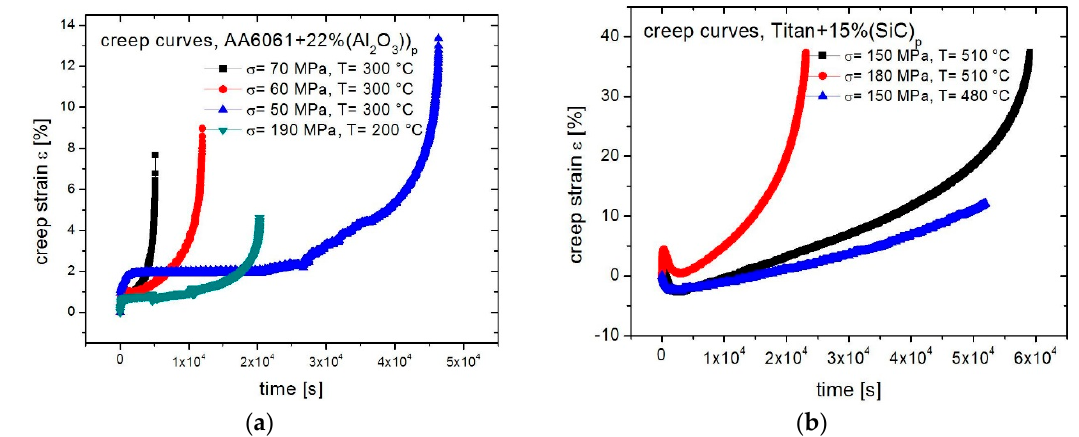
Figure 5. Creep curves: ( a ) AA6061 + 22% (Al 2 O 3 ) p ; ( b ) cp-Titanium + 15% (SiC) p.